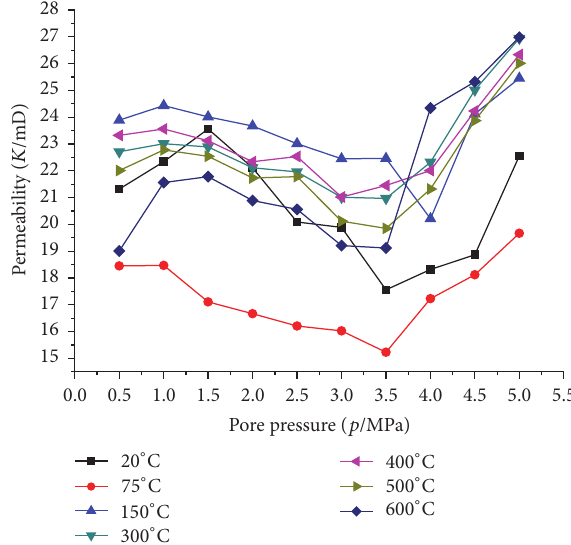
Figure 15: Variations of permeability with pore pressure at different